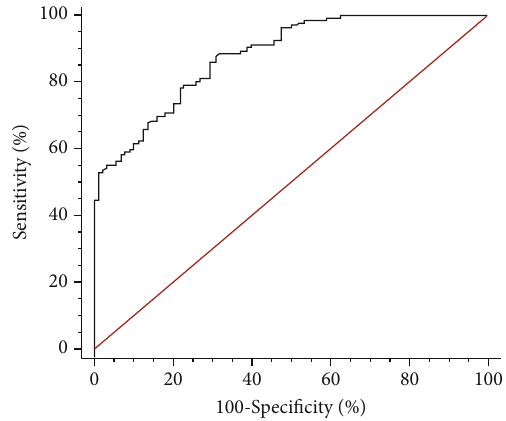
Figure 2: ROC curve for prediction of cardiovascular and cerebrovascular events in diabetic nephropathy patients receiving maintenance hemodialysis with the nomogram model.